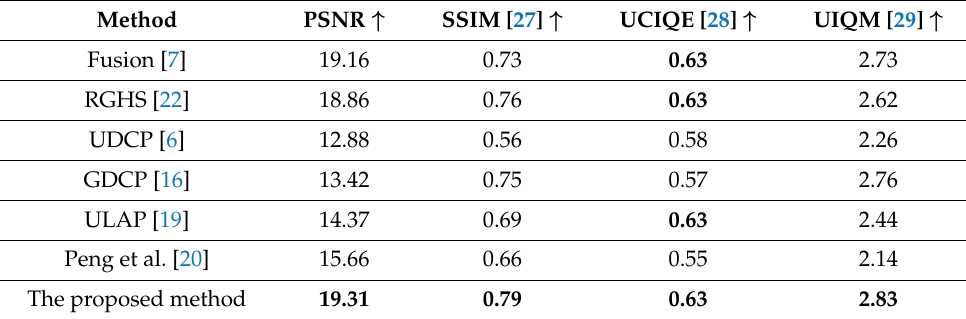
Table 1. Quantitative full-reference evaluation and non-reference evaluation of the proposed method and six other SOTA underwater image enhancement methods. The best results in terms of each metric are shown in